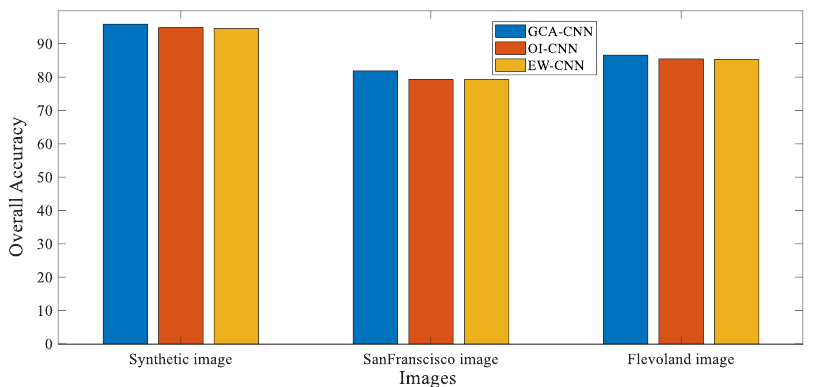
Figure 18. Accuracies of GCA-CNN, OI-CNN and the EW-CNN on three datasets. In Figure 18, it can be seen that the performance of the EW-CNN is obviously lower than the GCA-CNN. For the real SAR images with complex characters of terrains, the performance of EW-CNN is even lower than the OI-CNN. This phenomenon is caused by the inappropriate fusion which reduces the discrimination of the features, and consequently leads to lower classification accuracy. By the discussion above, the effectiveness of the adaptive fusion can be